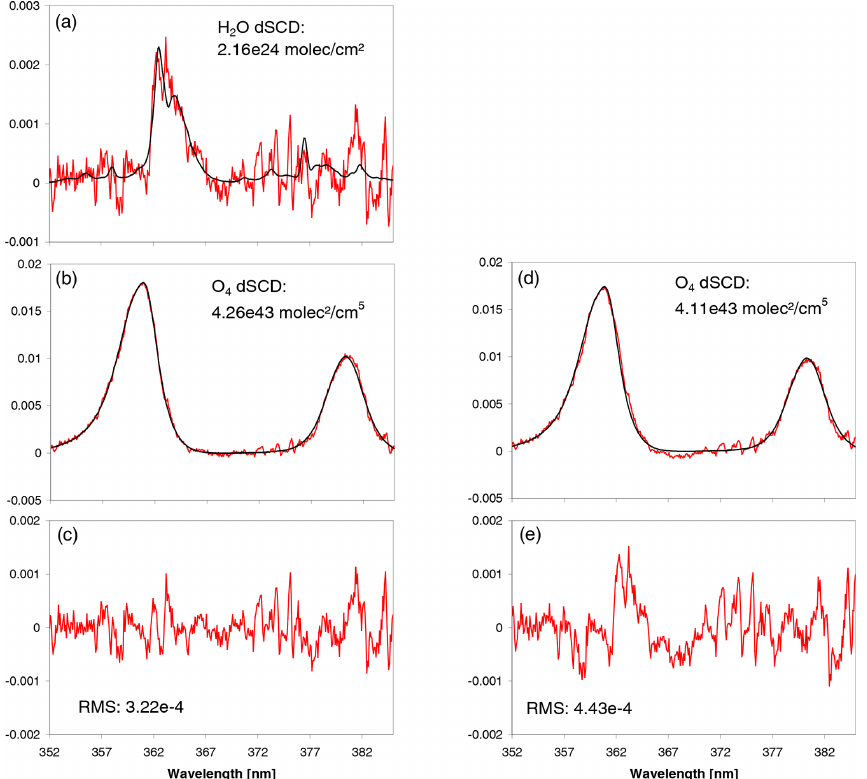
Figure A1. Fit results for a spectrum taken on 2 May 2019, 13:14:50UTC, at an elevation angle of 1 ◦ (SZA: 33.6 ◦ ). (a–c) Results if an H 2 O cross section is included in the spectral analysis; (d–e) results if no H 2 O cross section is included in the spectral analysis. The black lines represent the fitted cross section; the red lines indicate the residual (bottom) or the residual plus the fitted cross section.